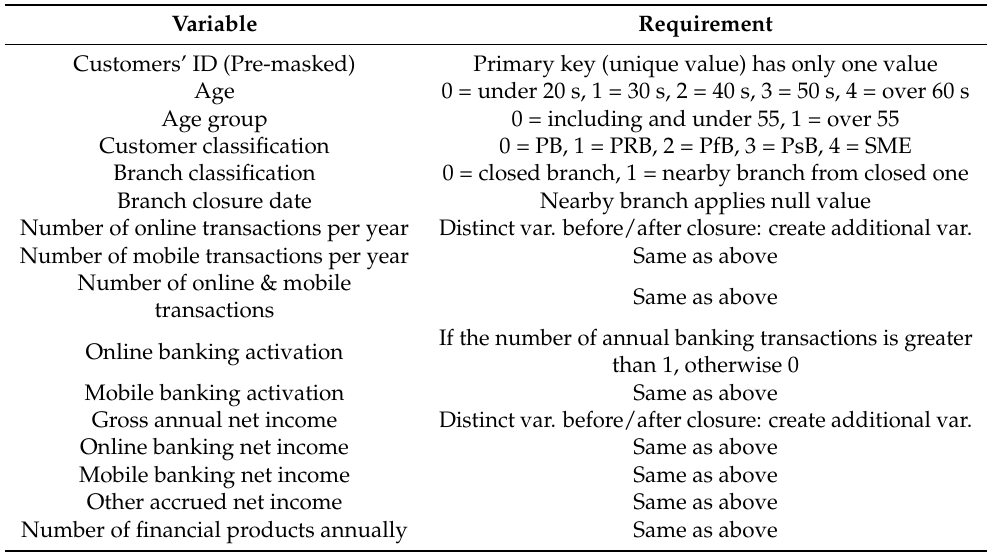
Table 3. Data classification and pre-processing.